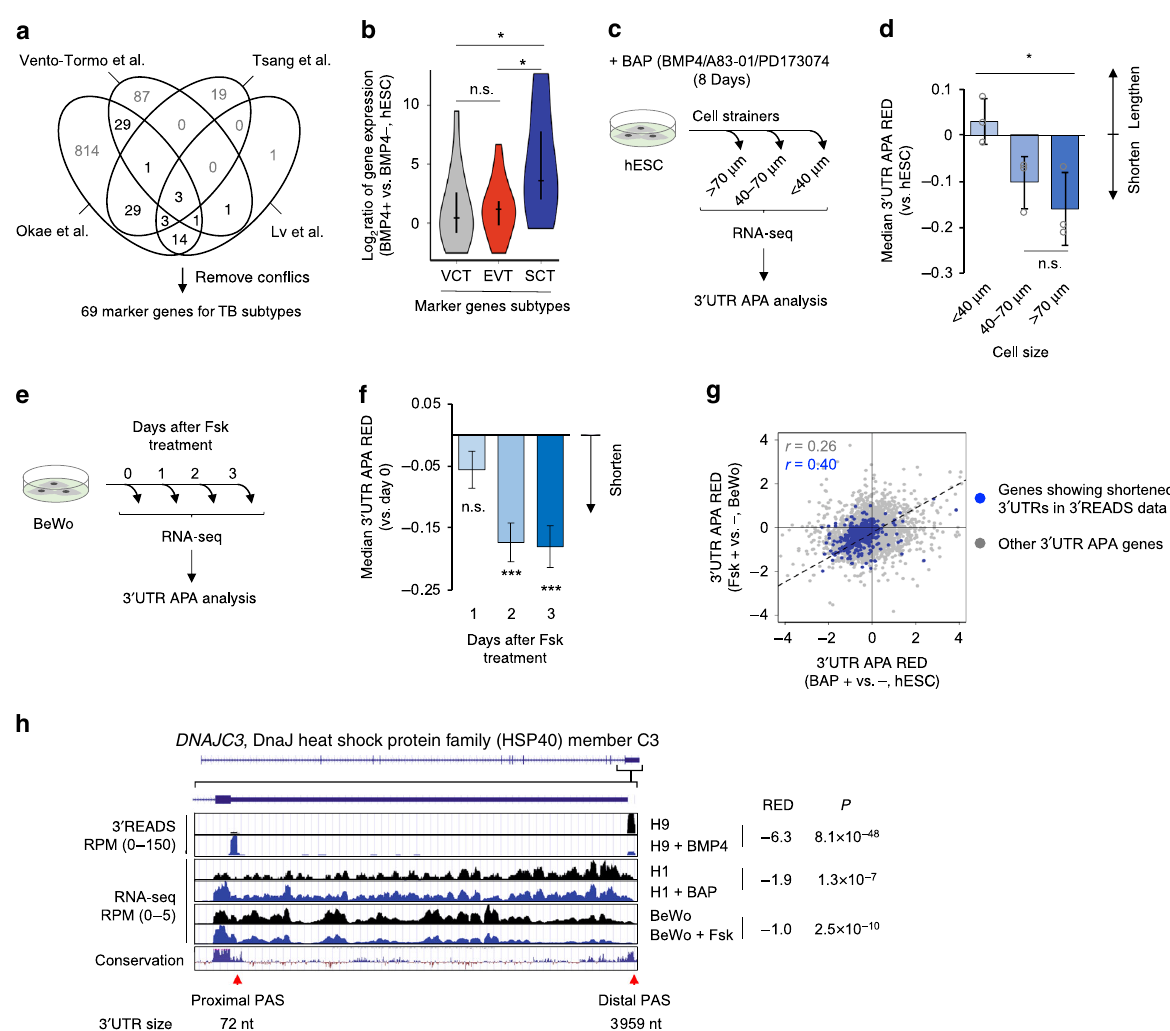
Fig. 3 Syncytialization of trophoblasts elicits 3 ʹ UTR shortening. a Venn diagram showing TB subtype marker genes based on four indicated publications. A panel of 69 marker genes were selected. Subtype marker genes were de fi ned by at least two studies (gene number shown in bold) and had no con fl icts across all four studies. b Violin plot showing expression changes of TB subtype marker genes in differentiation of hESCs into TBs by BMP4 treatment (Fig. 2a). Signi fi cance of difference between gene sets (Wilcoxon test) is indicated. c Schematic showing experimental design of the Yabe et al. 32 study, in which TBs differentiated from hESCs (H1 line) by BAP (BMP4, A83-01, and PD173074) were fractionated into different size groups by cell strainers. d Median 3 ʹ UTR APA REDs for different TB cell size groups vs. hESCs. Data are presented as mean value + / − SD of three replicates. Signi fi cance of difference ( t -test) between cell groups is indicated. A total of 8216 genes were used for analysis. e Schematic showing experimental design of the Azar et al. 34 study, in which BeWo cells were induced to syncytialize by forskolin (Fsk). f Median 3 ʹ UTR APA REDs for different days of Fsk treatment vs. day 0. Data are presented as mean value + / − SD based on bootstrapped data (20 times). Signi fi cance of difference ( t -test) with day 0 is indicated. A total of 7682 genes were used for analysis. g Scatter plot comparing 3 ʹ UTR APA REDs of hESC and BeWo RNA-seq data. Pearson correlation coef fi cients are indicated for genes showing 3 ʹ UTR shortening in the 3 ʹ READS data (blue dots, 1070 genes from Fig. 2c) and other genes displaying 3 ʹ UTR APA (gray dots, 7133 genes). h UCSC Genome Browser tracks showing data for the gene DNAJC3 . 3 ʹ READS data for the hESC model (Fig. 2a), RNA-seq data for the hESC model (>70 μ m TB cells vs. hESCs, Fig. 3c), and RNA-seq data for BeWo syncytialization (day 3 vs. day 0, Fig. 3e) are shown. The two APA sites and 3 ʹ UTR sizes for their corresponding isoforms are indicated. Sequence conservation based on 100 vertebrates is shown. REDs and P -values are